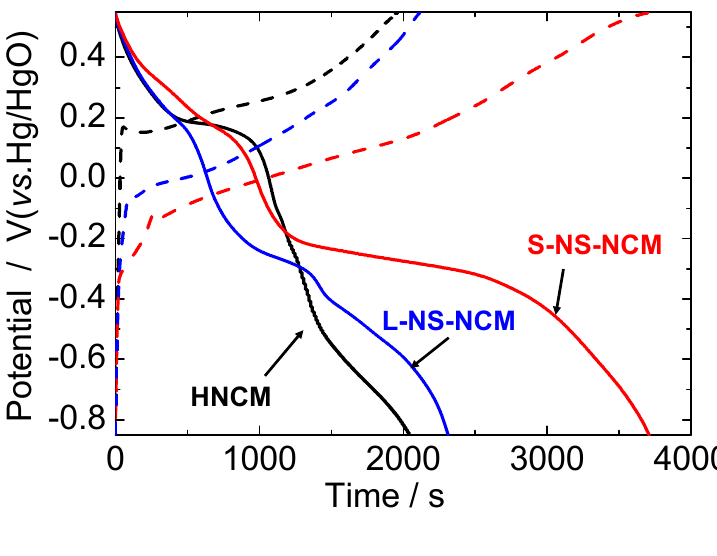
Figure 6. Charge/discharge curves for HNCM, L-NS-NCM, and S-NS-NCM at a current density of 300 mA·g − 1 . The potential range was − 0.85–0.55 V vs.